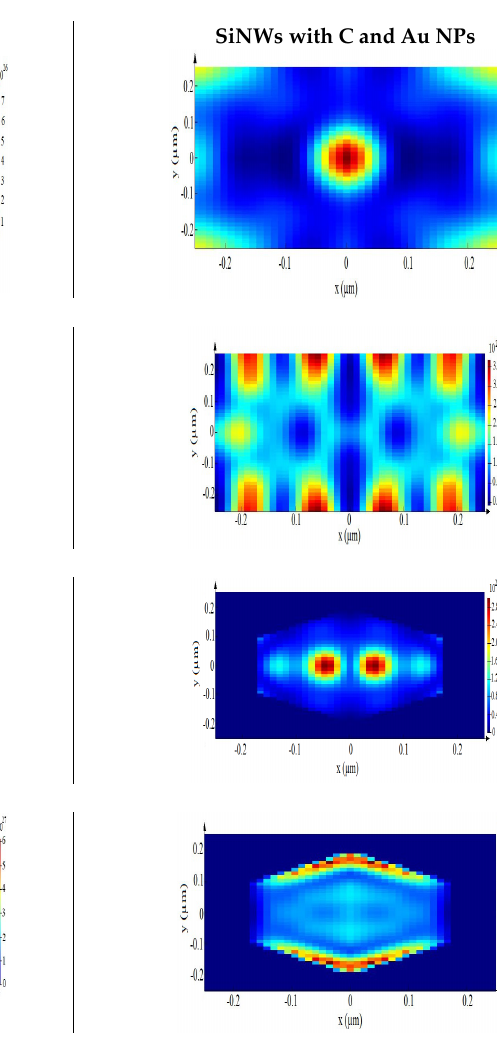
Figure 11. Optical power distribution at different monitoring layers for four different proposed structures.